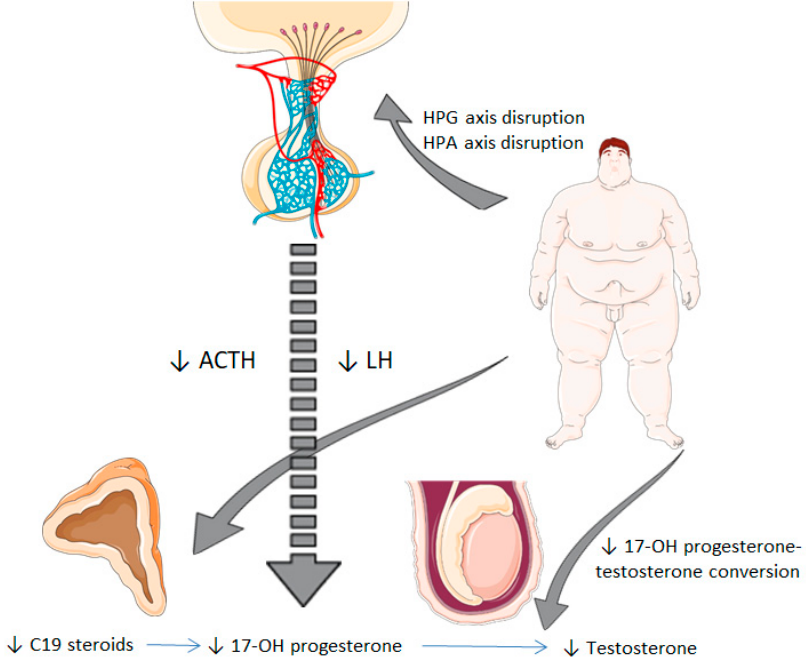
Figure 1. Potential mechanisms from obesity to decreased serum 17-hydroxyprogesterone levels. Obesity is associated with a disruption of the hypothalamic–pituitary–gonadal axis, which involves an impaired synthesis of LH. This fact leads to reduced testicular synthesis of 17-OH progesterone and testosterone. Besides, obesity could also alter the hypothalamic–pituitary–adrenal axis at a central level (impaired secretion of ACTH) and adrenal level (reduced synthesis of C19 steroids), which results in decreased 17-OH progesterone levels. HPG, hypothalamic-pituitary-gonadal; HPA, hypothalamic-pituitary-adrenal; LH: luteinizing hormone; ACTH: adrenocorticotropic hormone; 17-OH progesterone, 17-hydroxyprogesterone.